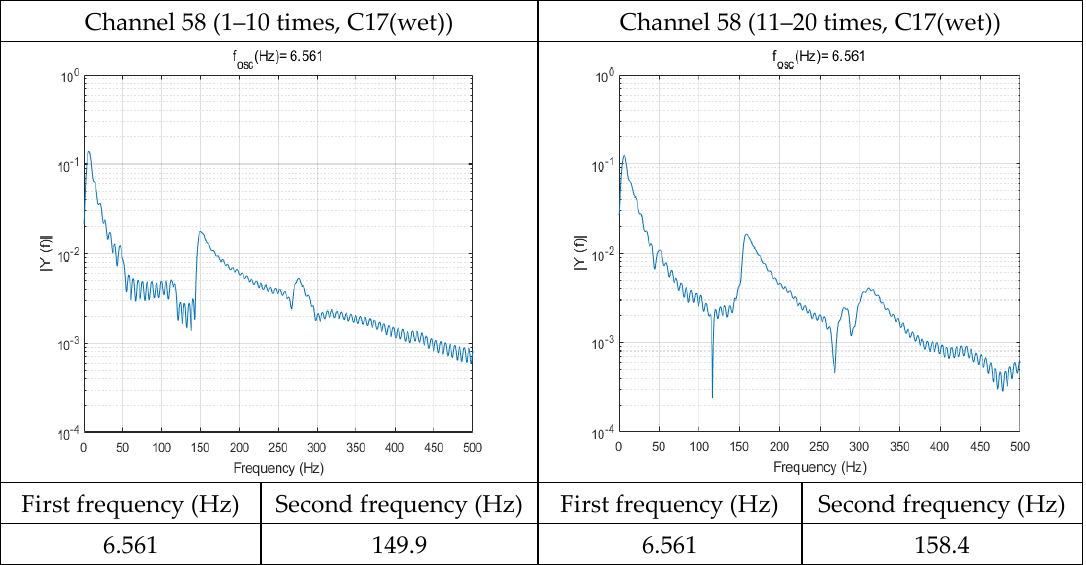
Figure 19. FFT of Channel 51 (Wet Condition, SWAY)